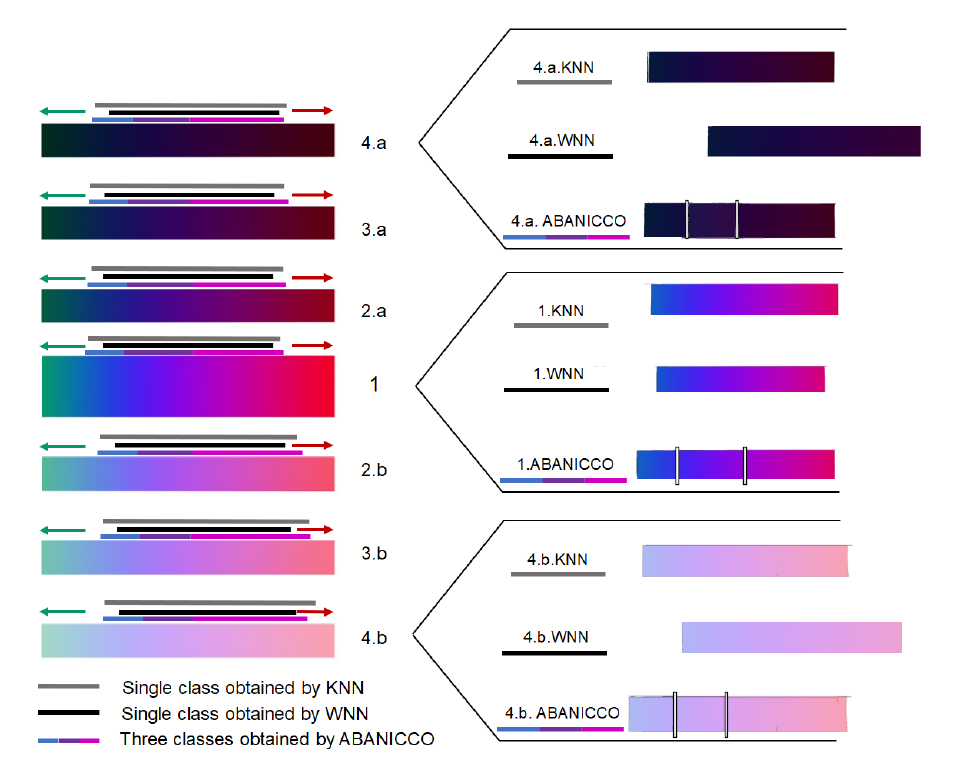
Figure A3. Closer look at the comparison of color classification by machine learning methods and our method using the area marked in Figure A2. This evaluation was carried out in 7 rectangles depicting the concept of shadows and tones of a portion of the color wheel. Rectangle 1 shows the portion of the color wheel from bluish-green to red. The rectangles above this were obtained by adding an increasing quantity of black to represent shades (Rectangles 2.a, 3.a, and 4.a). The rectangles below were obtained by adding an increasing quantity of gray to represent tones (Rectangles 2.b, 3.b, and 4.b). The figure displays the results of color classification over the region covering the purplish-blue and pinkish-red colors. The region’s exact limits and length depended on the shape of the class created by each method. Above each rectangle, three different lines measured the length of the segmentations by each approach, for this portion of the color wheel: the solid gray line corresponded to the k-nearest neighbors algorithm (KNN); the solid black line to the Wide Neural Network (WNN); the tri-color line to our method. A solid color line represents both Machine Learning methods, because they failed to create appropriate boundaries between blues, purples, and pinks. By contrast, our method is represented using three colors, because it obtained three different classes in all the experiments, regardless of tonality. To both sides of these lines are arrows indicating the classes obtained before and after this section; the actual segmentation performed by the three methods on rectangles 4.a, 1, and 4.b is shown to their right. The separation between classes of our method is marked with white lines for